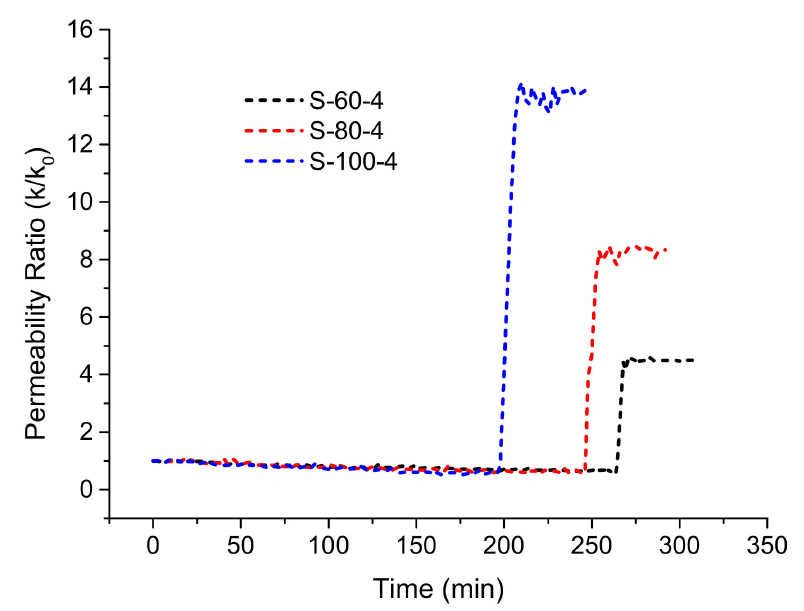
Figure 3. Evolution of the coal permeability ratio with time under different N 2